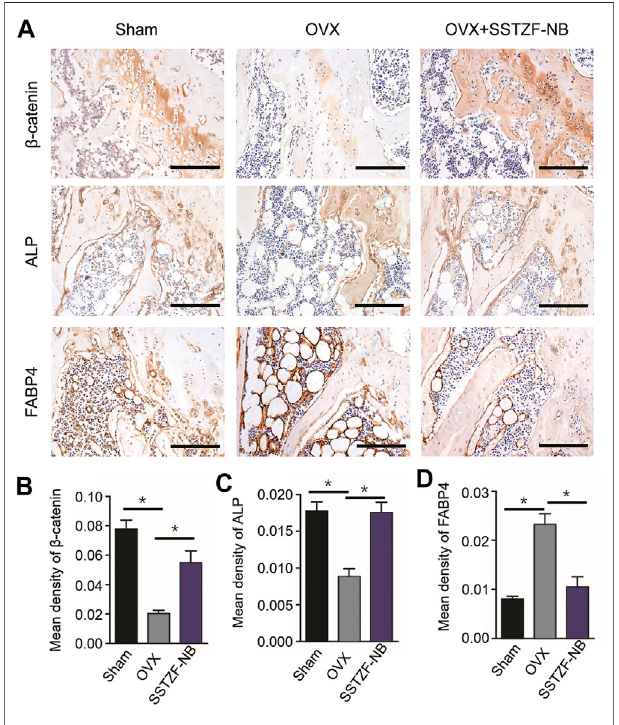
FIGURE 4 | SSTZF-NB enhances osteogenesis and inhibits adipogenesis via activating β -catenin in mice. (A) Representative IHC staining images of β -catenin in growth plate chondrocytes, ALP, and FABP4 in the area of the chondro-osseous junction. Semi-quantitative analysis of positive expression of β -catenin (B) , ALP (C) and FABP4. (D) Scale bars: 1,000 μ m * p < 0.001.